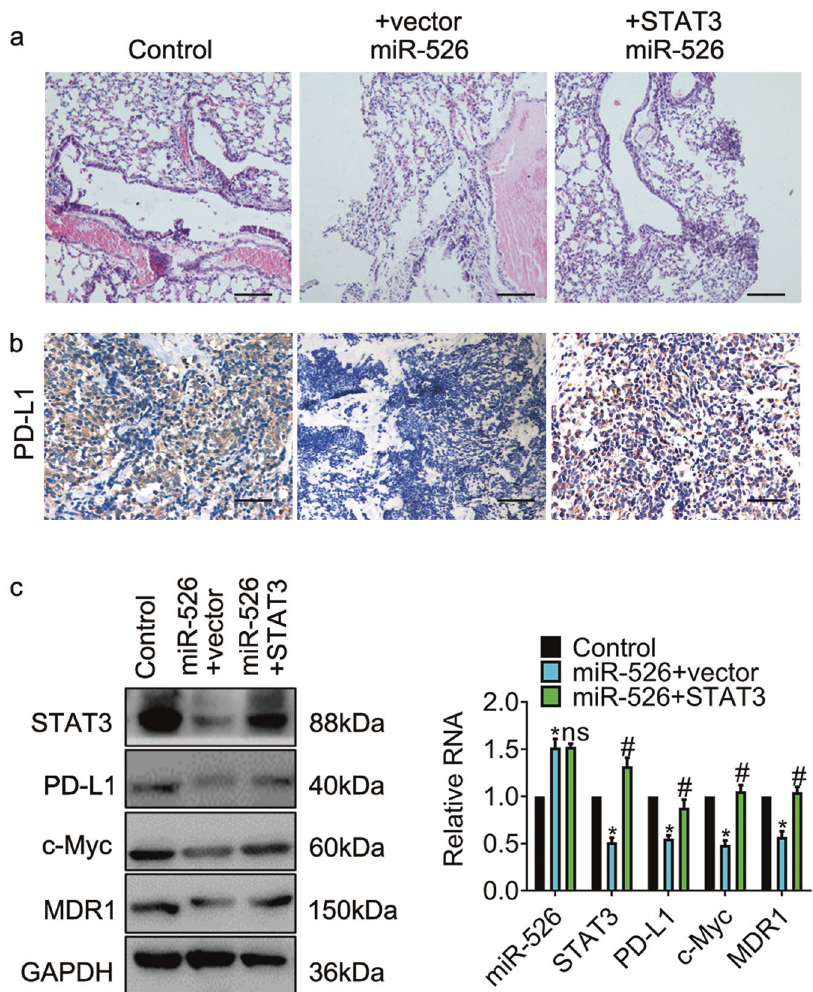
Fig. 6 STAT3 overexpression reverses the inhibition of miR-526b-3p in cancer metastasis. a The representative images of lung metastasis by hematoxylin and eosin stains are shown. Scale bar, 20 µm. b The representative images of PD-L1 expression by immunohistochemical stain are shown. Scale bar, 50 µm. c The expression of the indicated genes is determined by western blot and qRT-PCR, respectively. *, P < 0.05 vs. control. #, P < 0.05 vs miR-526b-3p plus